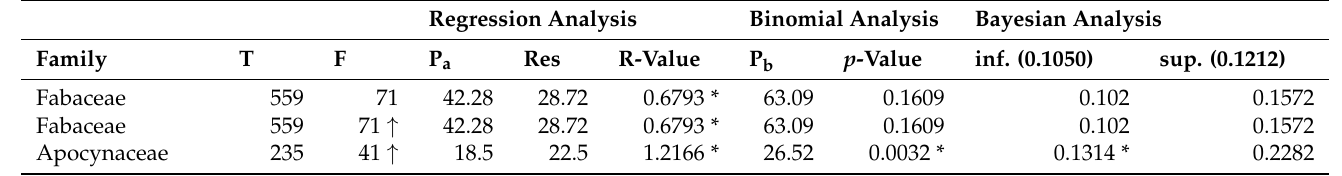
Table 4. Quantitative analysis of food families. T—total number of species in the flora; F—food species; ↑ / ↓ —positive/negative outliers based on residuals; P a —predicted food species under regres- sion model; P b —predicted food species under binomial model; inf.—Bayesian inferior 95% probability credible intervals; sup.—Bayesian superior 95% probability credible intervals; *—positive